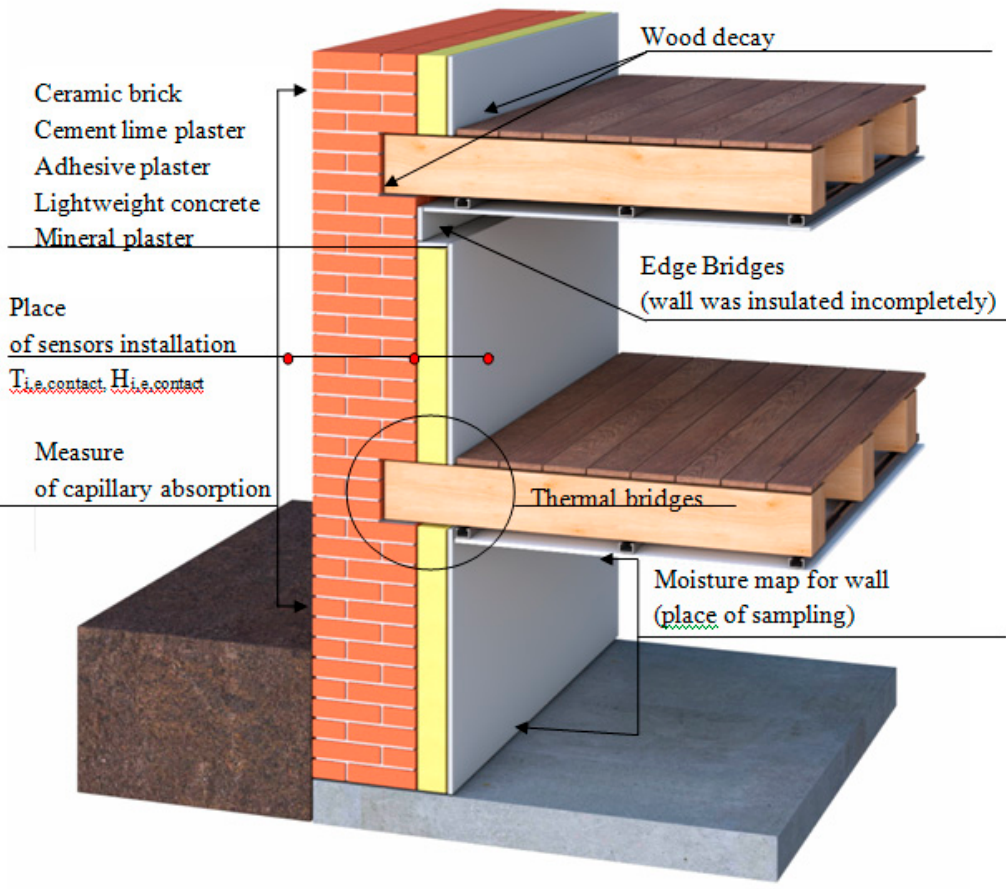
Figure 1. Scheme of the test bench with description.